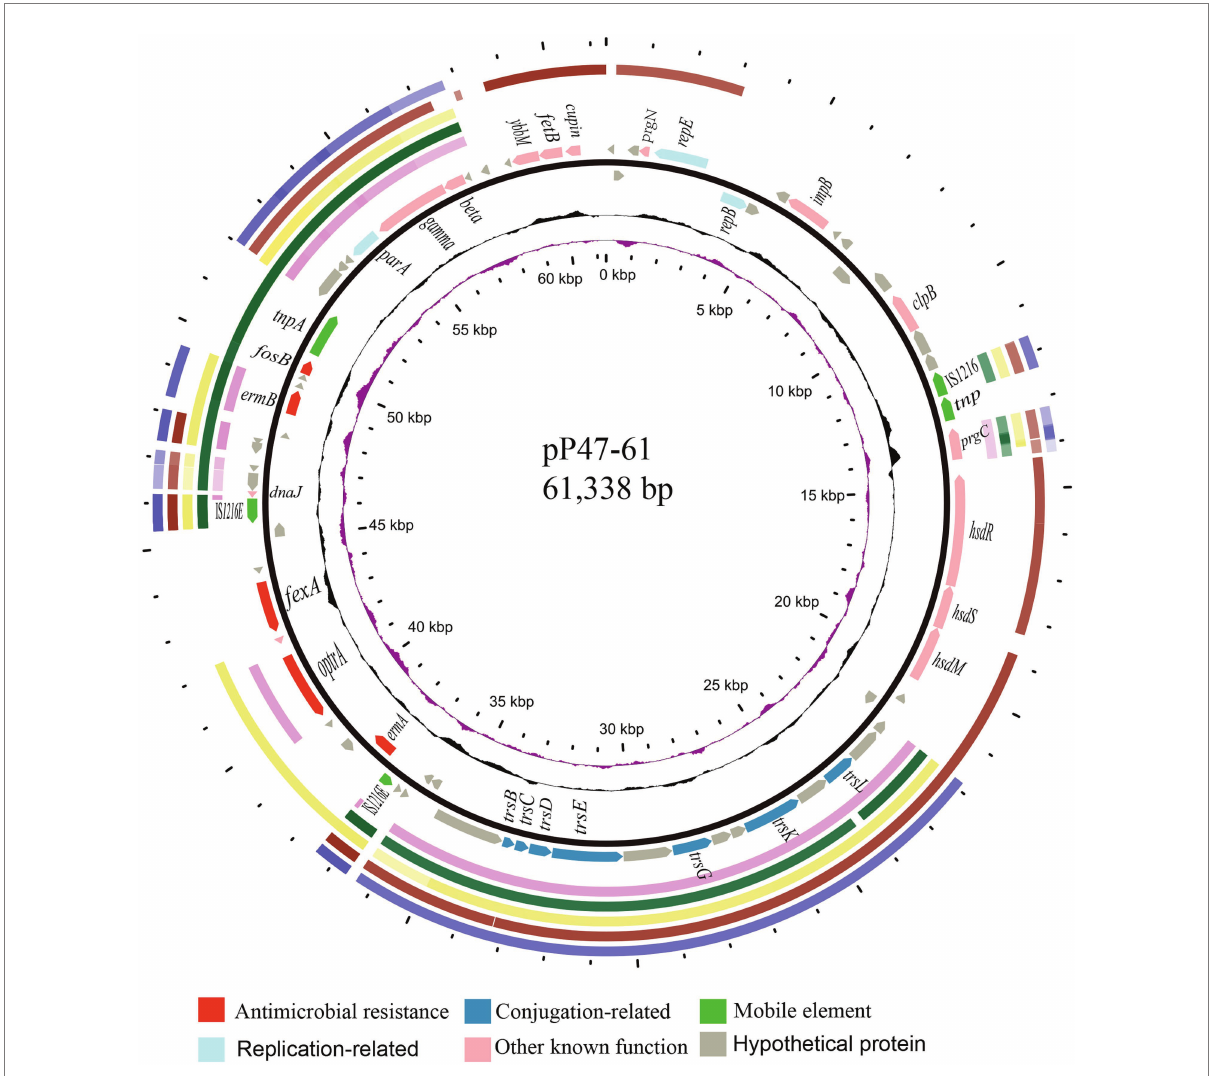
FIGURE 4 Comparative plasmid analysis of pP47-61 and other similar sequences. Circles from outside to inside indicate (1) the regions of the four plasmids (all from Enterococcus, including pCR1B, CP030934.1; pF120805, KY579372.1; pKUB3007-3, AP018546.1; and pE35048-oc, MF580438.1) and a transposon sequence of the Staphylococcus aureus AOUC-0915 chromosome (Tn 6349, MH746818.1), which share high homology with pP47-61. (2) Predicted coding sequences encoded on the forward and reverse strands of pP47-61. (3) G + C content (with an average of 50%, in which a G + C content of more than 50% is shown toward the outside and less is shown inward) and G + C skew (with a positive GC skew toward the outside and a negative GC skew toward the inside) of pP47-61. (4) The innermost circle shows the position in